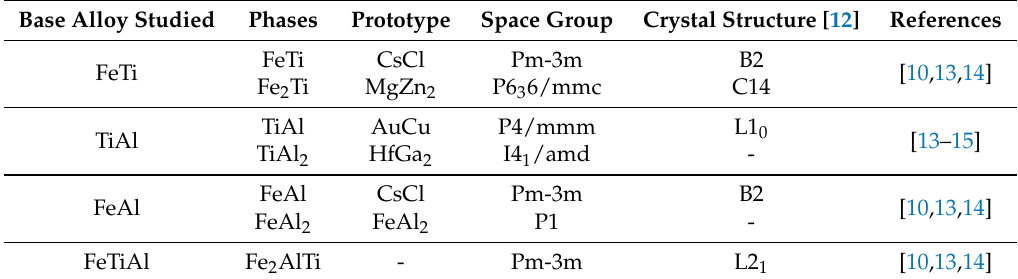
Table 1. The observed phase in the binary and ternary systems